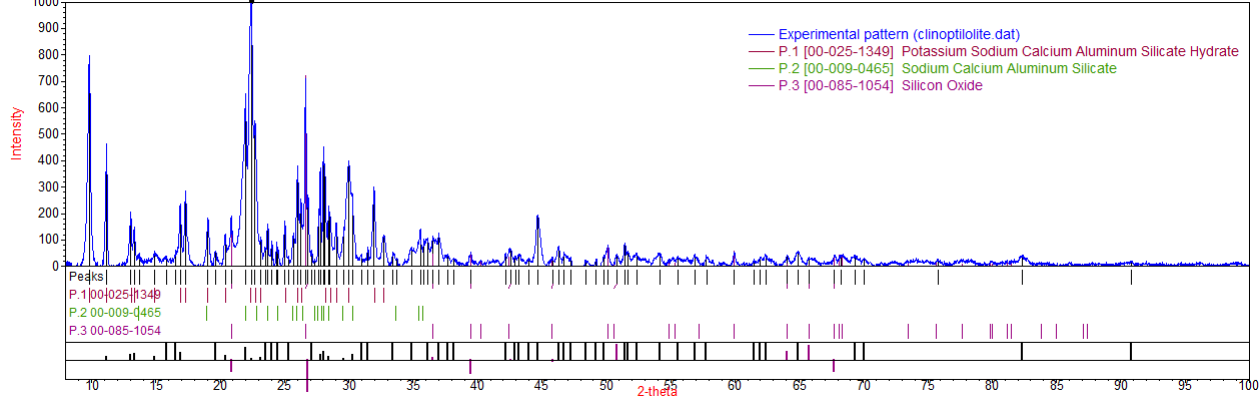
Figure 1. XRD of the natural zeolite used for fabricating the impedimetric water sensor with indica- tion of peaks of the clinoptilolite crystalline